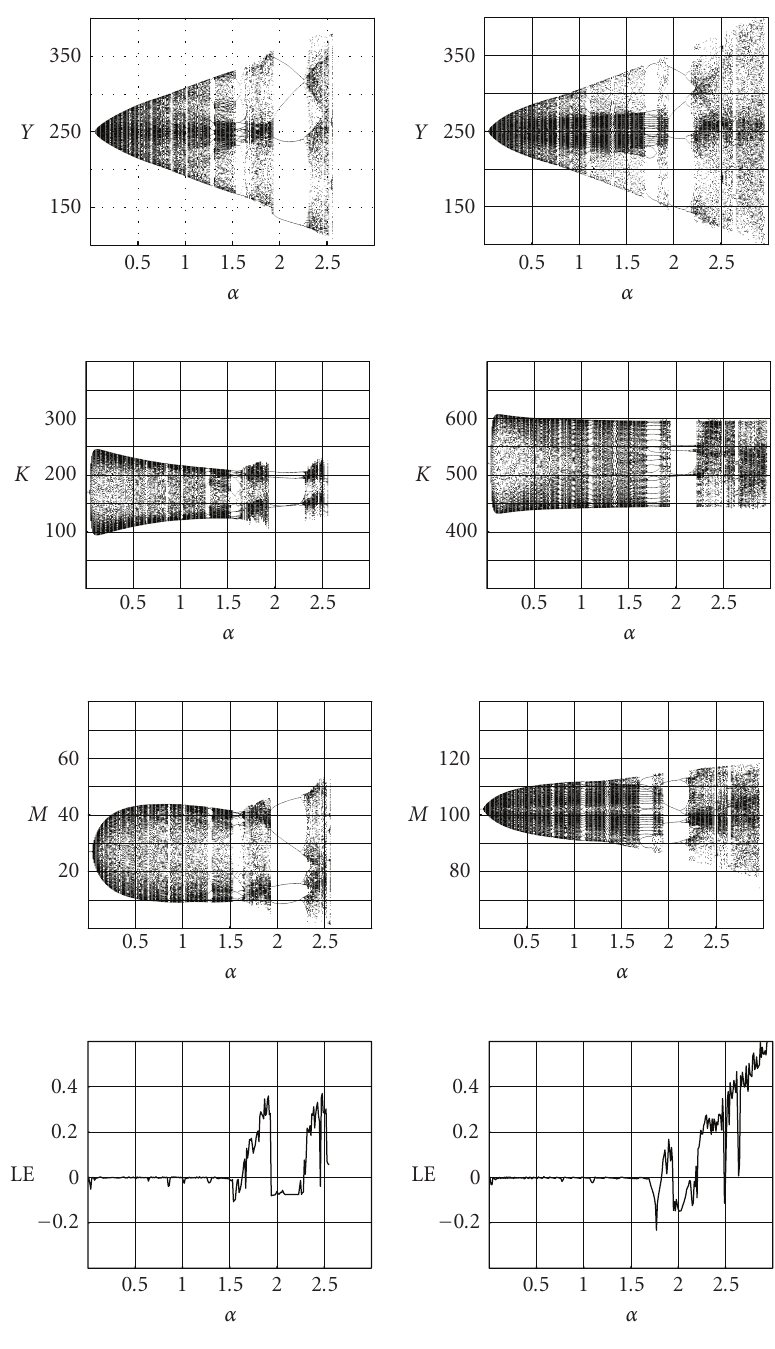
Figure 5.1. Bifurcation diagrams and Lyapunov exponent for β = 0 . 2 (left) and β = 0 . 5